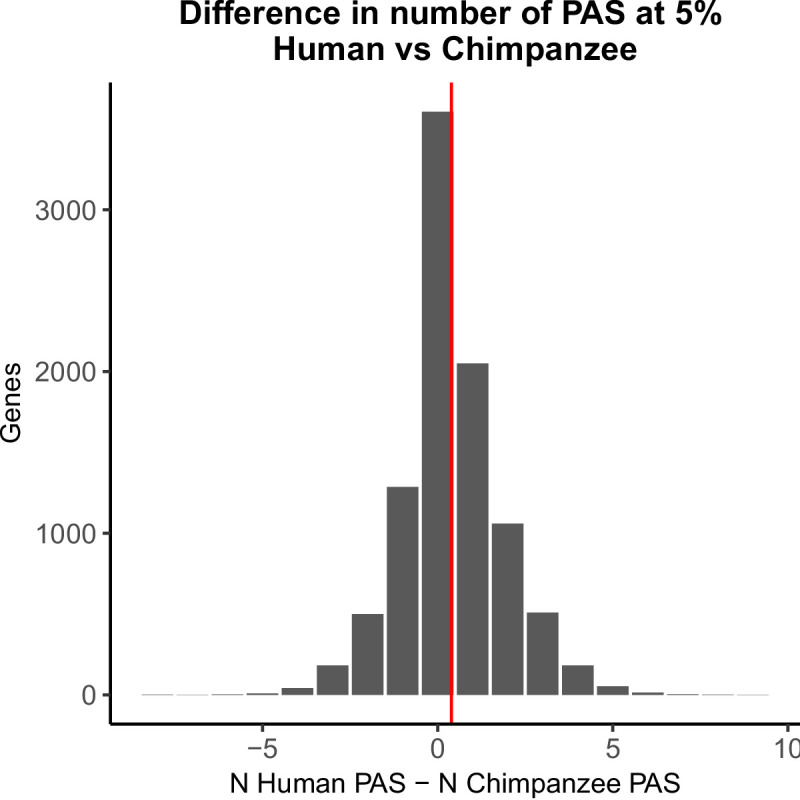
Polyadenylation sites (PAS) detection likely not biased by species.Histogram of the number of PAS detected at 5% usage in human minus the number of 5% usage in chimpanzees. Red vertical line represents mean difference (0.39).